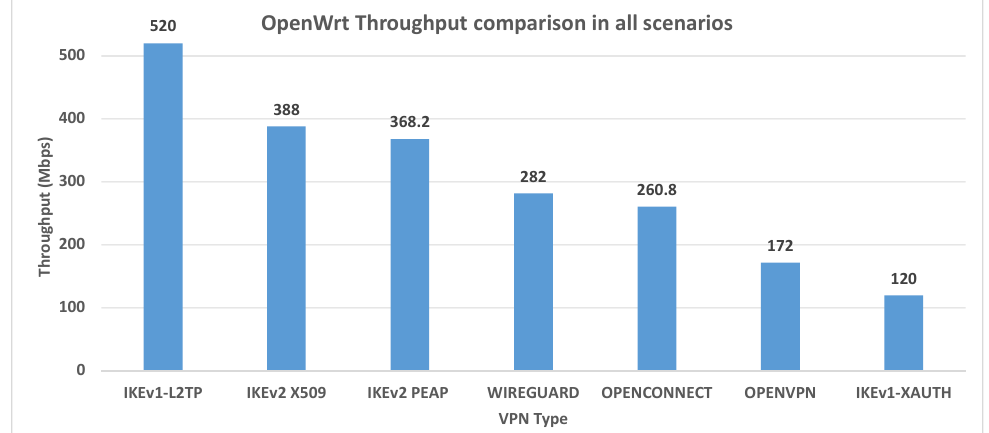
Figure 28. Comparison of Throughputs on OpenWrt in all